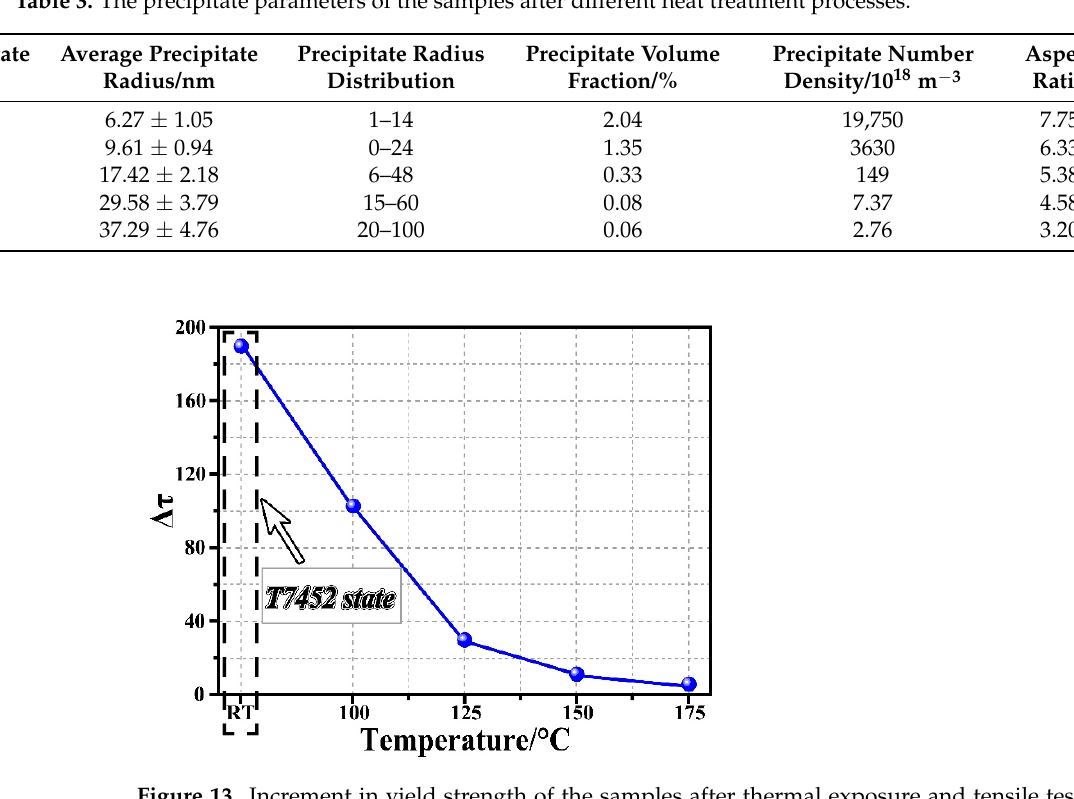
Figure 13. Increment in yield strength of the samples after thermal exposure and tensile tests at different temperatures.